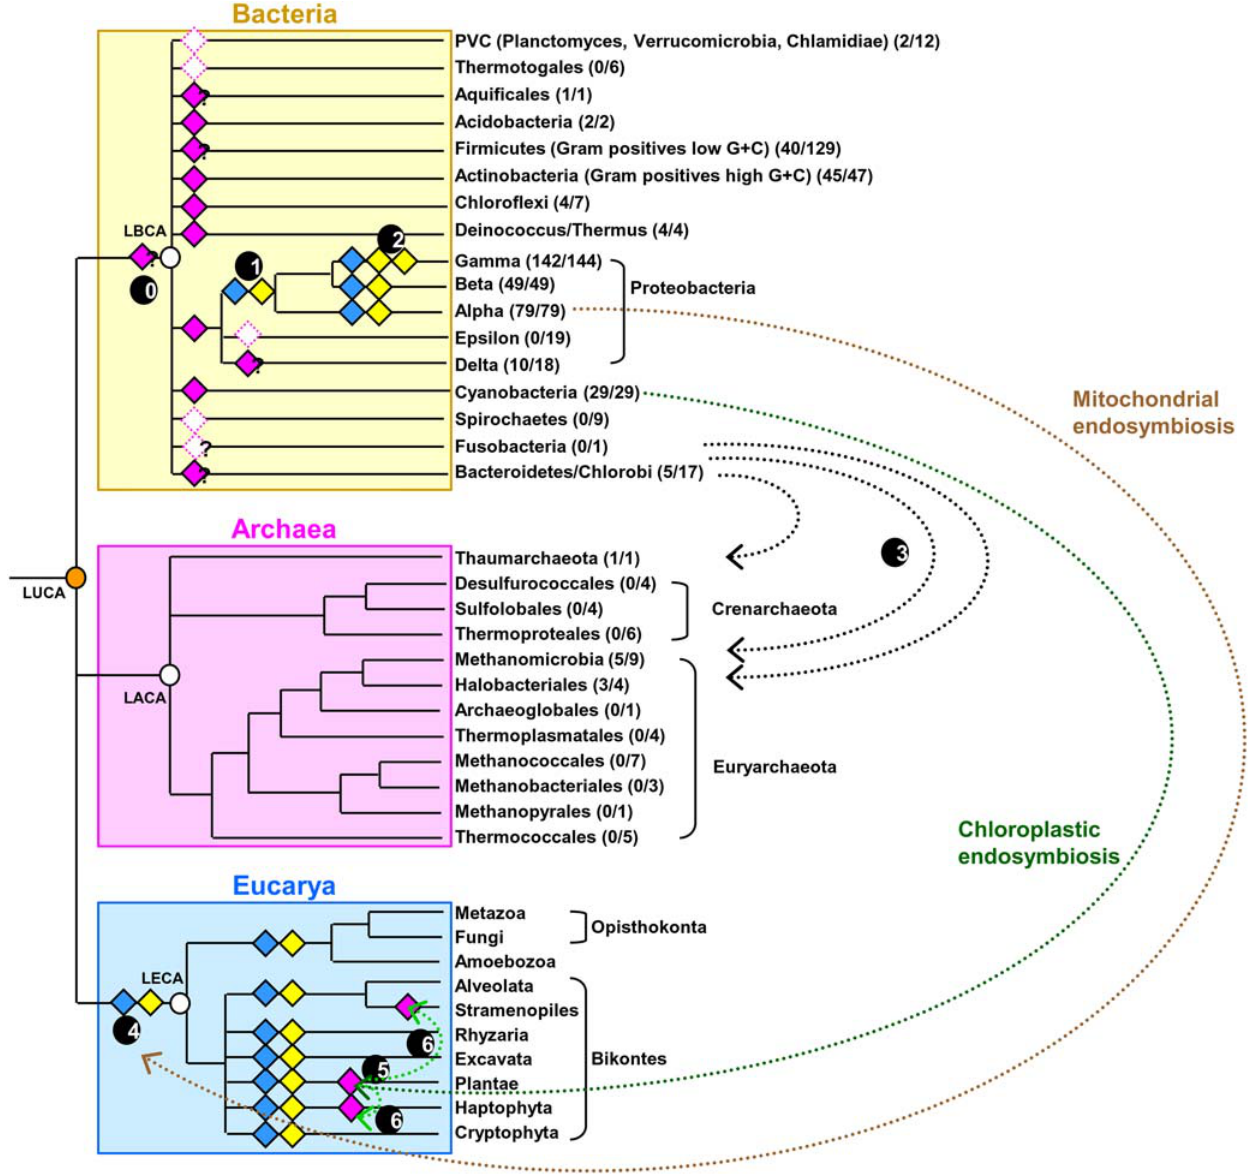
Figure 1. Model for ATC protein evolution. Schematic representation of the universal tree of life, for which complete genome sequences are available. LUCA (Last Universal Common Ancestor), LECA (Last Eukaryotic Common Ancestor), LACA (Last Archaeal Common Ancestor) and LBCA (Last Bacterial Common Ancestor) are indicated by orange and white circles. For each prokaryotic phylum, the number of genomes encoding at least one ATC homolog with respect to the number of complete available genomes is given between brackets. Filled-diamonds indicate the presence of an ATC encoding gene in the ancestor of a given lineage: pink diamonds designate ATCs; blue diamonds symbolize ATC-I and yellow diamonds represent ATC-II. Dotted empty diamonds symbolize the loss of the corresponding ATC ancestor encoding gene in the lineage. Arrows schematize horizontal gene transfer events (HGT). The distribution and phylogeny of ATC proteins suggest that they originated in the bacterial domain (black circle number 0) and were thus absent in LACA. The inference of ATC encoding genes in the ancestor of most bacterial phyla ( i.e. Acidobacteria, Chloroflexi, Actinobacteria, Cyanobacteria, Deinococcus/Thermus, Alpha-, Beta and Gamma-Proteobacteria) suggests that an ATC encoding gene was present in LBCA. Accordingly, the absence of any ATC encoding gene in PVC, Thermotogae, Epsilon-Proteobacteria, and Spirochaetes suggests ancestral losses whereas the ancestral presence or absence of ATC encoding genes in Bacteroidetes/Chlorobi, Delta-Proteobacteria, Aquificae, Fusobacteria and Firmicutes cannot be definitively inferred. In nearly all Alpha-, Beta- and Gamma-Proteobacteria, at least two ATC encoding genes are present, suggesting their presence in the ancestor of these lineages (blue and yellow filled-diamonds). The evolutionary event at the origin of these two copies cannot be definitively inferred (acquisition through HGT of a non-proteobacterial bacterial sequence or duplication of the native copy, black circle number 1). The acquisition of a third copy in Gamma-Proteobacteria through a duplication event or an HGT occurred later (black circle number 2). The presence of few ATC encoding genes in Archaea likely results from several independent HGTs from different bacterial donors (black arrows and black circle number 3). The two ATC encoding genes found in nearly all eukaryotes are orthologs to the two copies found in Alpha- Proteobacteria and were very likely acquired through the mitochondrial endosymbiosis by their last common ancestor (brown arrow, black circle number 4). The third ATC encoding gene found in Plantae was likely acquired through the primary chloroplastic endosymbiosis (dark green arrow and black circle number 5) and spread to other photosynthetic eukaryotes through secondary chloroplastic endosymbioses (black circles number 6).